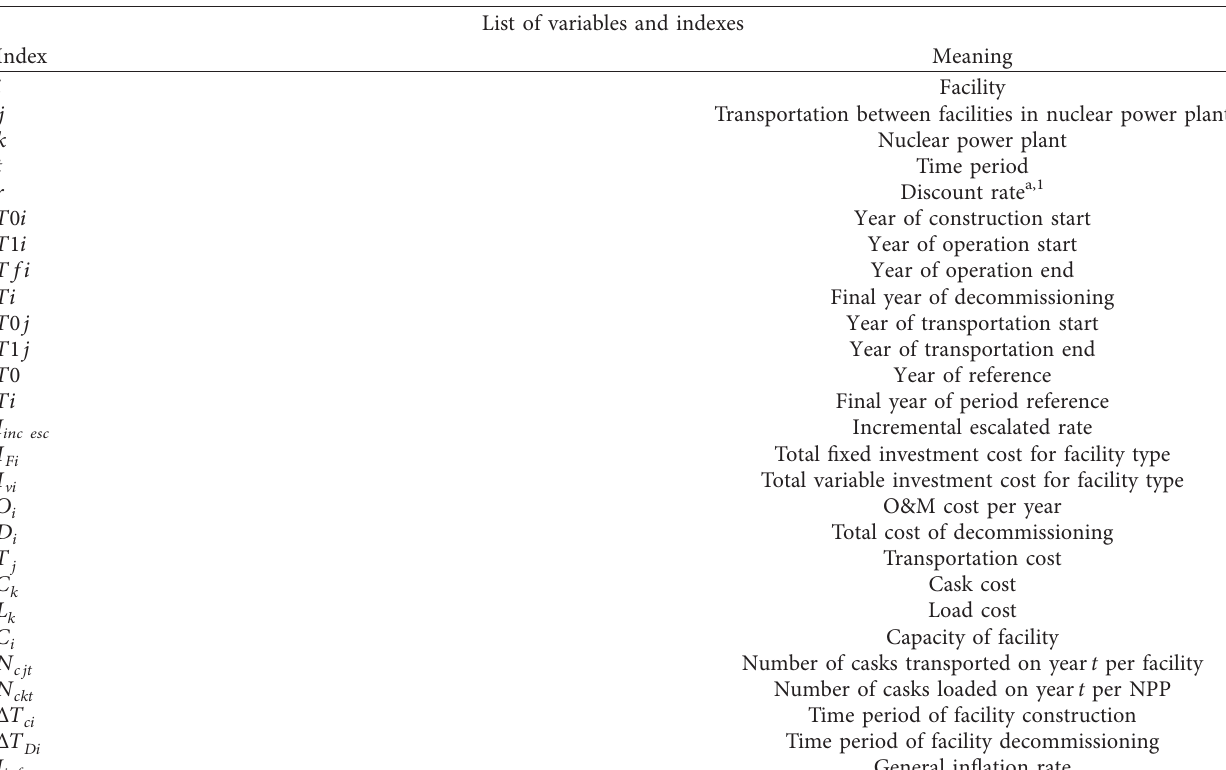
Table 11: Definitions of variables and indexes in equations (1) to